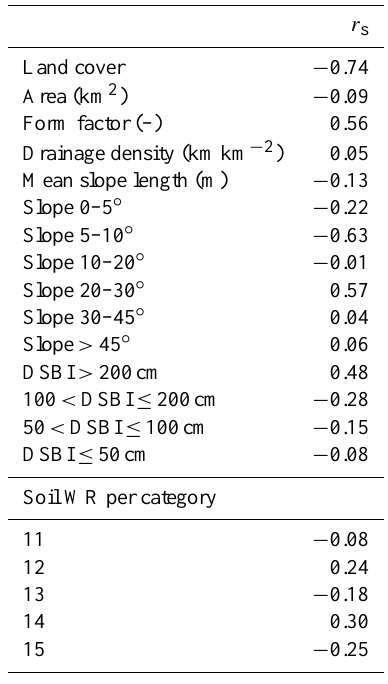
Table 5. Spearman’s rank correlation coefficients ( r s ) between base- flow MTT and land cover, catchment area, topographic characteris- tics, and subsurface hydrologic properties for the study catchments.